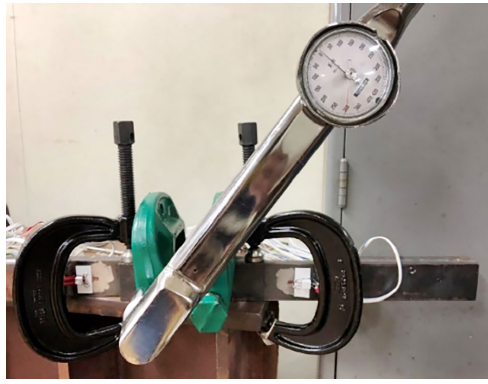
Figure 9. Introducing the torque of 300 Nm by torque-wrench